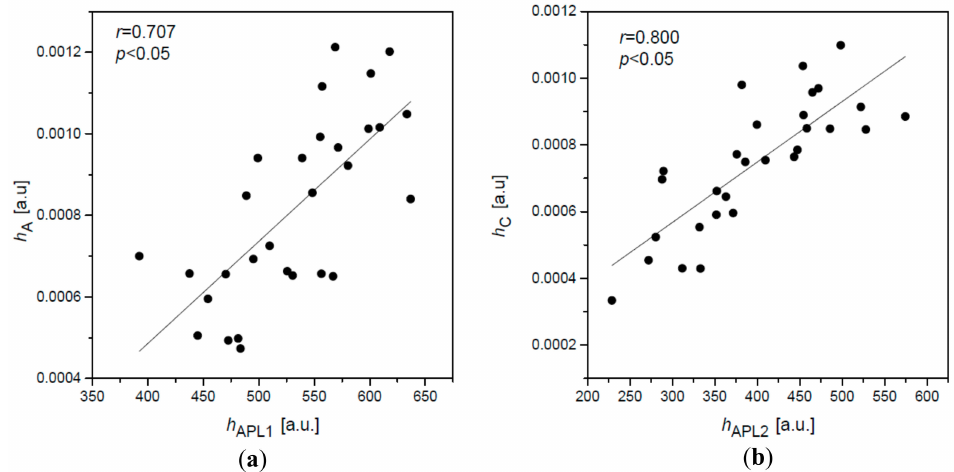
Figure 5. Dependence between the height h A of the A oscillations of the 2nd derivative and the height h APL1 of the first applanation peak ( a ), the height h C of the third oscillation C, and the peak height h APL2 of the second applanation ( b ) for the subject No. 2. Units of both axes refer to air pressure units (second derivative) and the applanation curve units, respectively.